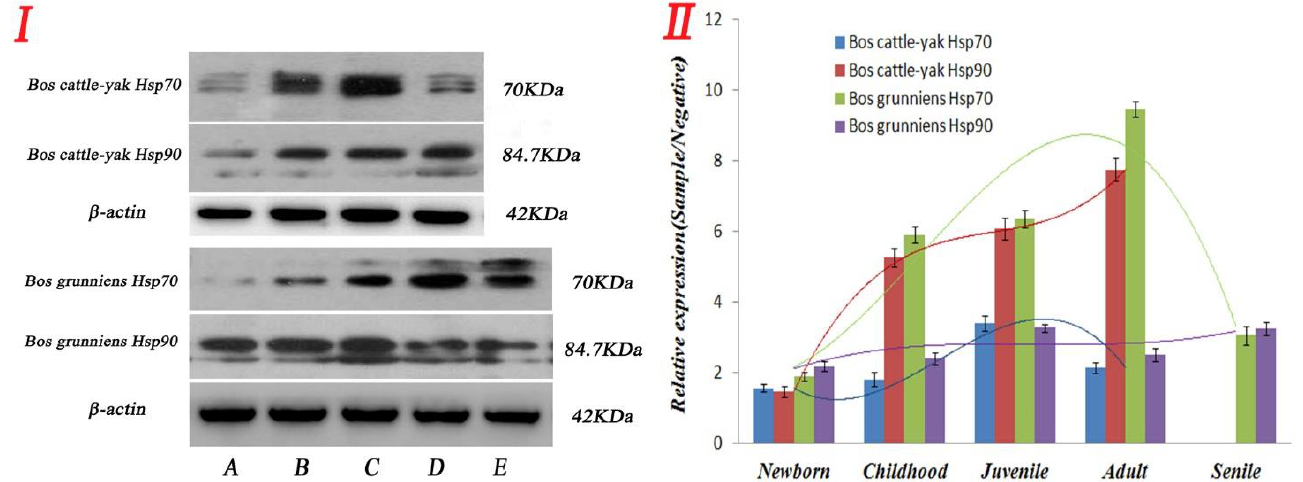
Figure 6. Hsp70 and Hsp90 expression in testicular tissue of cattle – yak and yak. ( I ) Schematic diagram of labeled bands and their sizes. ( II ) Different colors represent expressions of Hsp70 and Hsp90 in different testicular tissues from cattle – yak and yak.